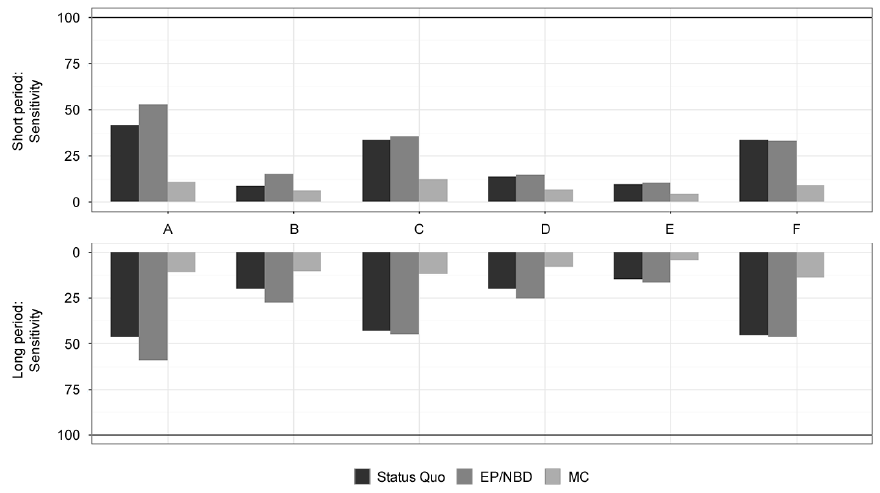
Figure A3. Results for MAE (customer-level, in %) for online stores A-F. Source: Authors.